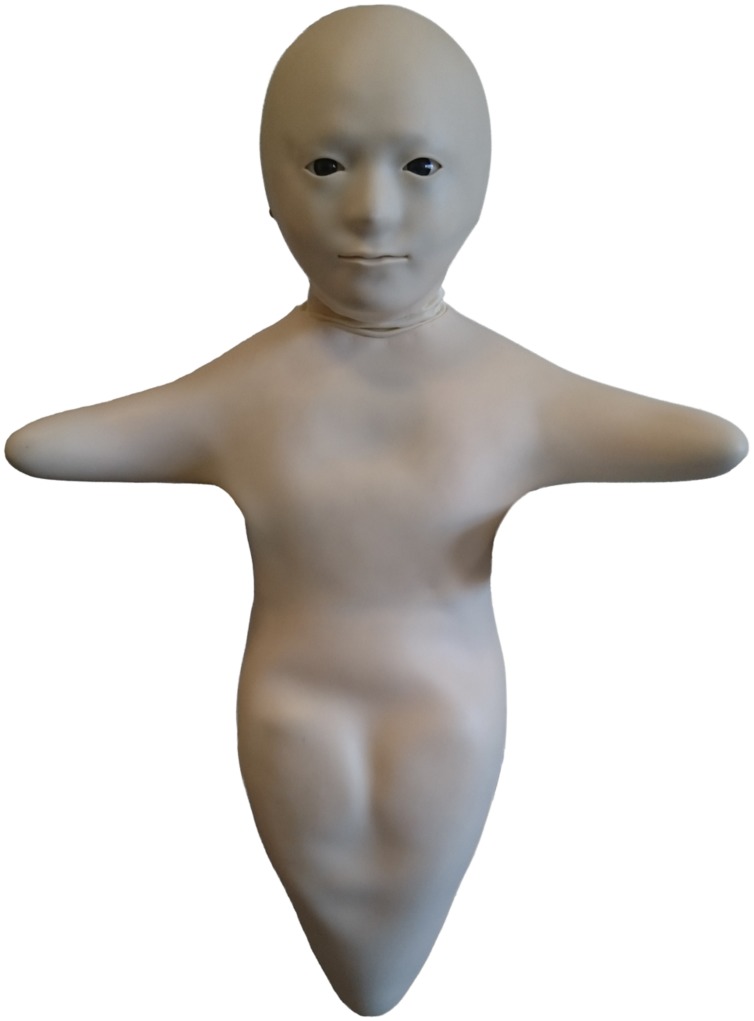
The Telenoid robot.